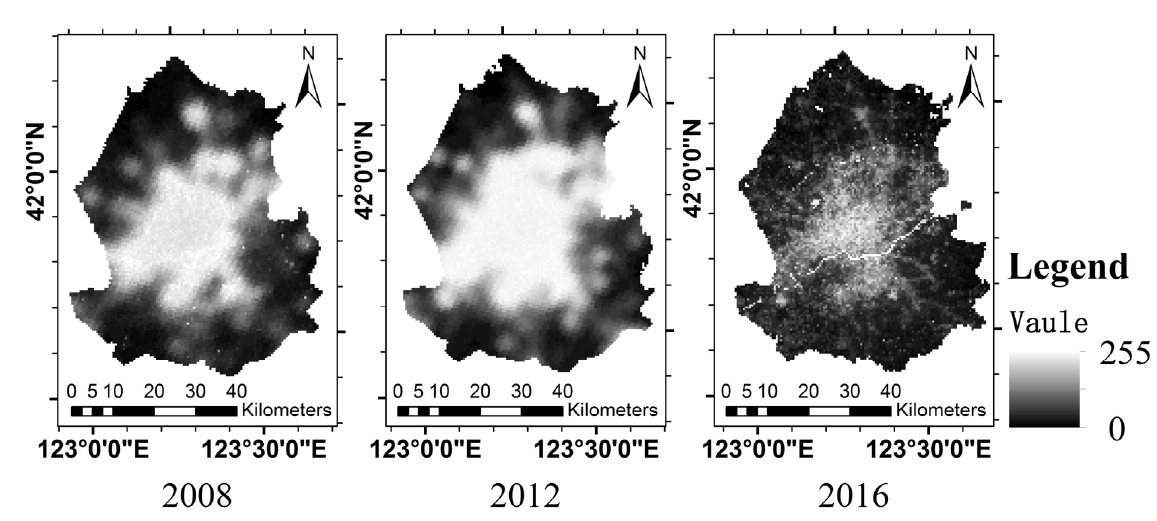
Figure 5. Shenyang NDUBI images.